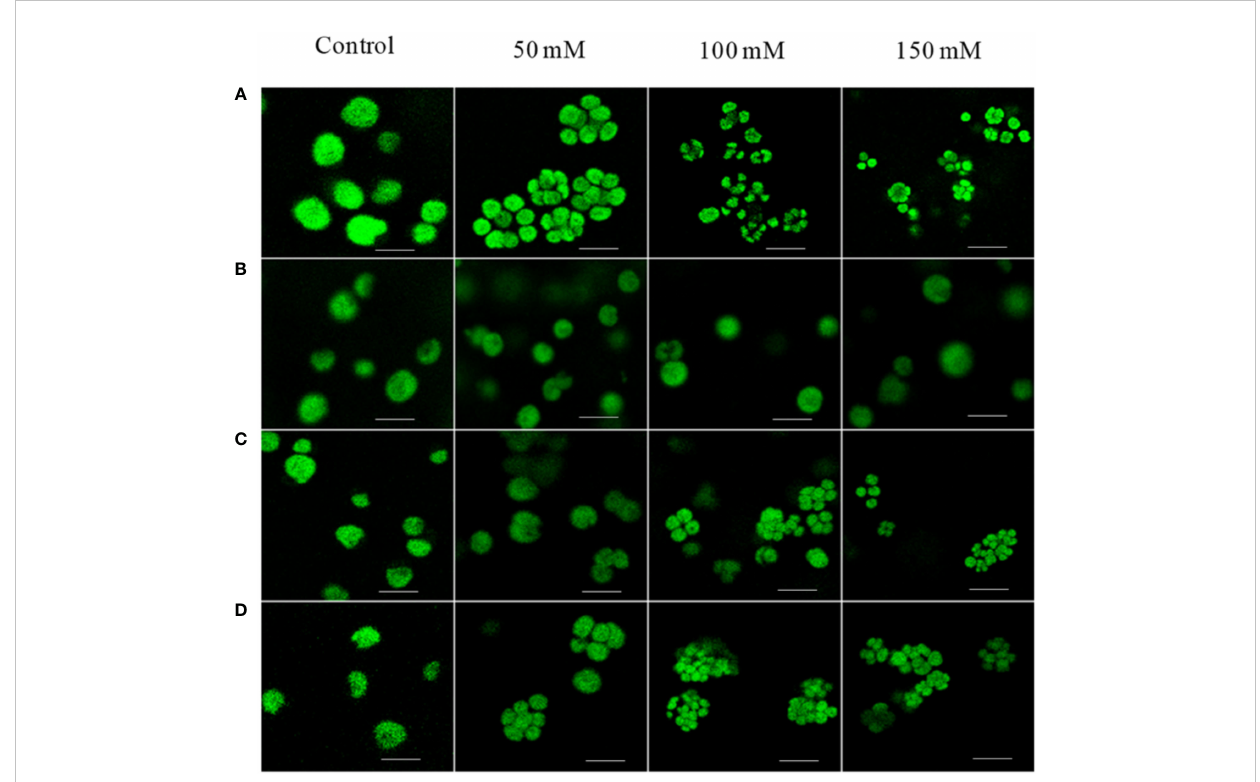
FIGURE 1 Confocal microscopy images of C. reinhardtii strains: WT, cell-wall mutant CC-503 grown in media with different NaCl concentrations (50, 100, and 150 mM; control, no addition). (A) WT strain showing palmelloid formation under all NaCl concentrations, (B) cell-wall-mutant (CC)-503 strain; palmelloid formation was absent under all NaCl concentrations. Palmelloid formation in the WT strain was noticed in (C) from 50 to 150 mM potassium acetate (CH 3 COOK), and (D) from 50 – 150 mM potassium chloride (KCl) concentrations. A scale bar of 10 µm was maintained for all the